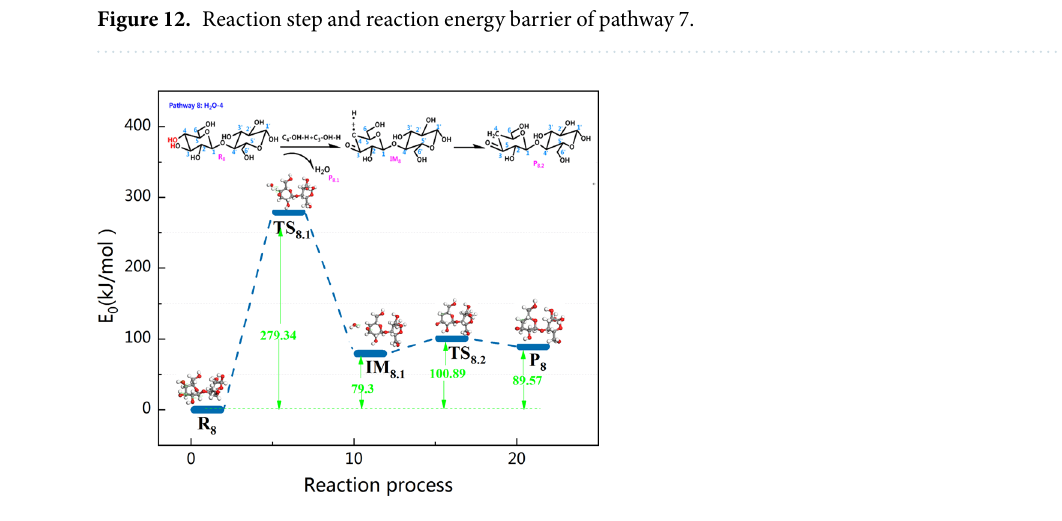
Figure 13. Reaction step and reaction energy barrier of pathway